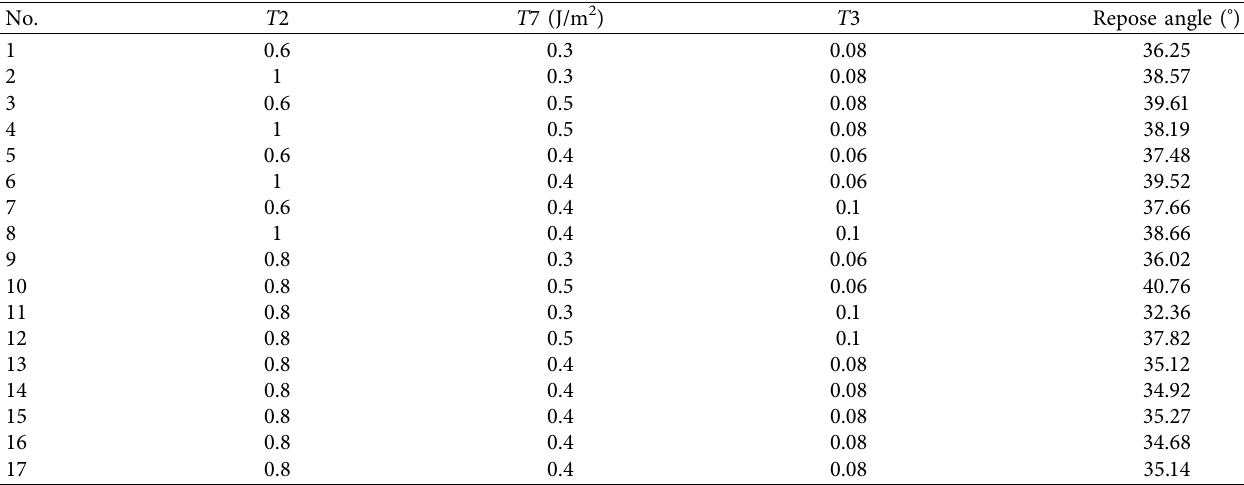
Table 6: Results of the B-BD simulation test.